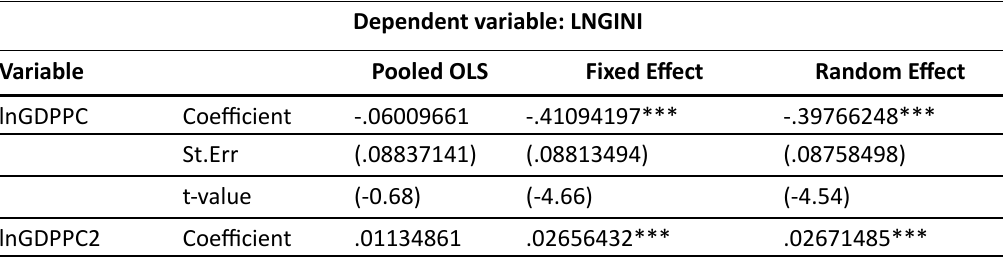
Table 3: Testing Kuznets Hypothesis